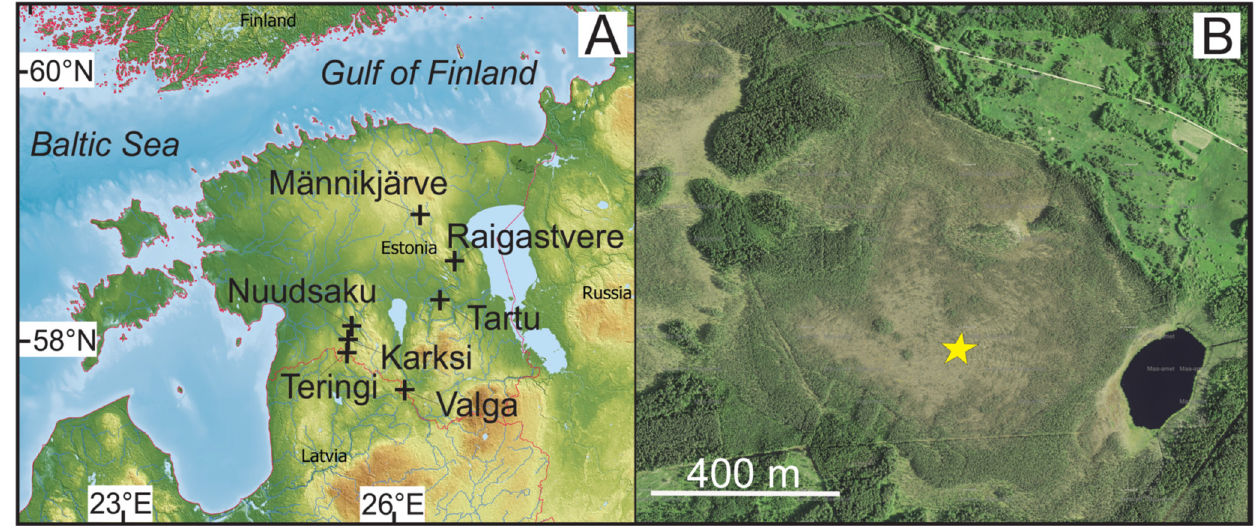
Figure 1. Location map of the study site panels ( A ) and orthophoto of Teringi Bog panels ( B ). The yellow star indicates the sampling well and coring location (57°58 ′ 33.56 ″ N, 25°33 ′ 30.90 ″ E). The biodiversity at Teringi is similar to other peatlands in southern Estonia